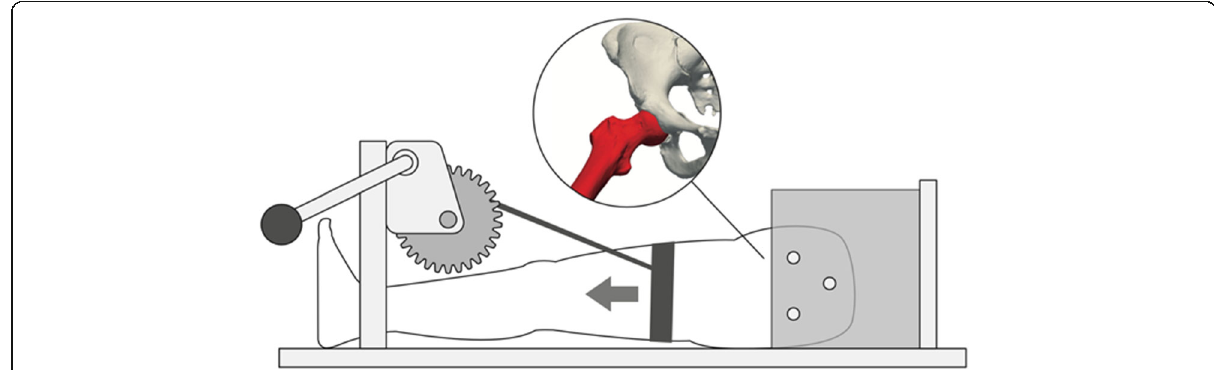
Fig. 2 The surgical setup. The pelvis was mounted in a portable fixture using three spiral drills. Traction was applied using a winch which could be adjusted in height to change flexion angles during